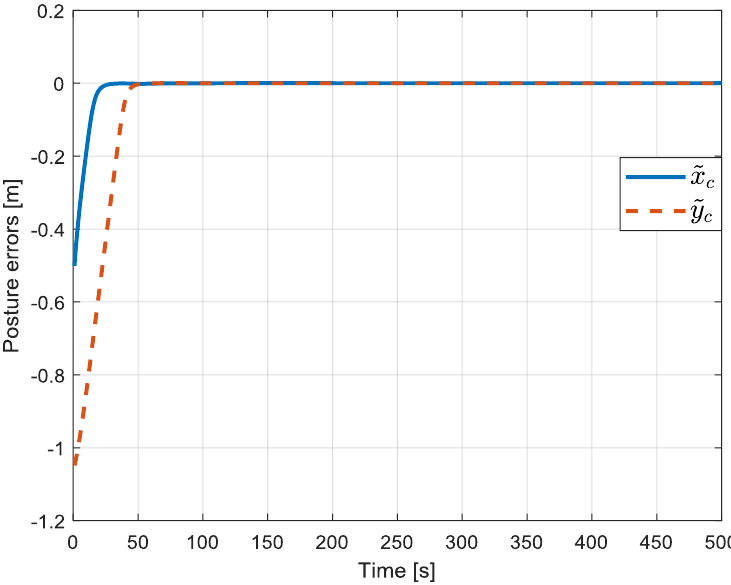
Figure 15. Errors in the posture of the leaders